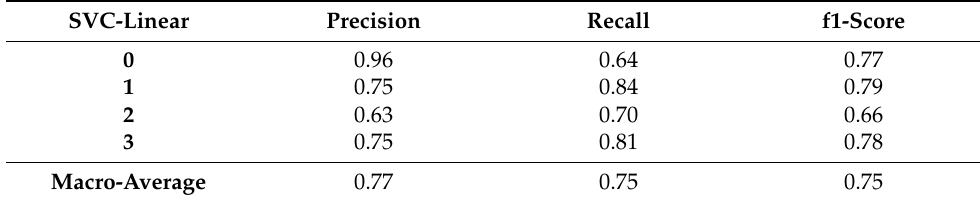
Table 7. Performance of